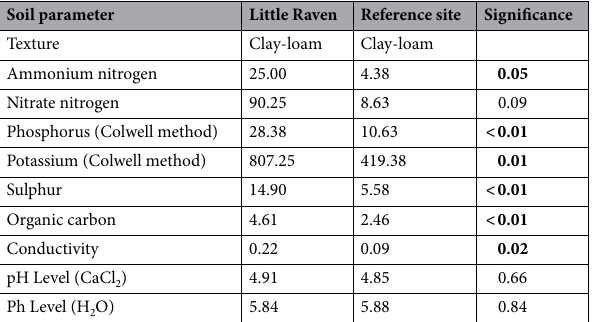
Table 3. Soil nutrients and other parameters of the Little Raven study site and the reference site. Significance was set to p = 0.05 and these values are in bold. The soil data for the reference site was provided by Steve Sinclair (Victorian State